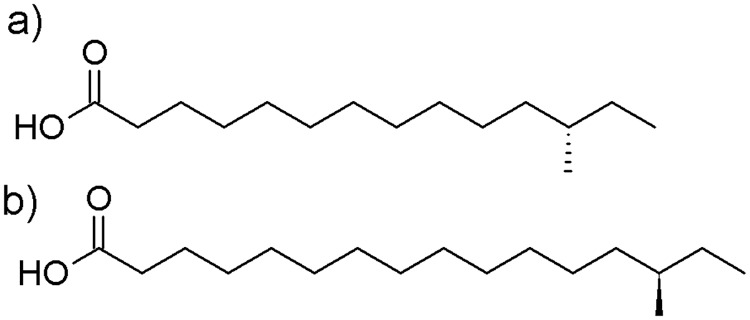
Chemical structure of (a) (S)-12-methyltetradecanoic acid (a15:0) and (b) (R)-14-methylhexadecanoic acid (a17:0).